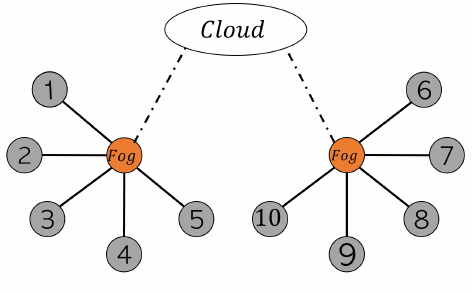
Figure 6. Undirected graph of communication between edge devices and fog servers for synchronous FL.